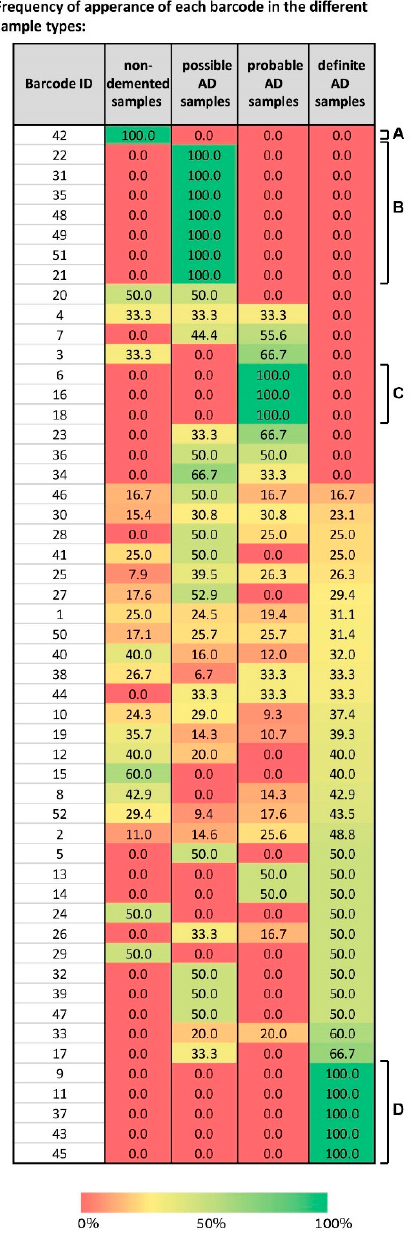
Figure 7. A spectrum of barcodes characterizes the 951 samples in the dataset, suggesting that we shift our conception of the molecular events in AD. The table presents the 52 barcodes identified in the dataset of 951 samples. For each barcode its frequency of expression in every sample type is shown. For example, blocks of barcodes characterizing solely one type of sample are evident (A, B, C, and D). However, the majority of the barcodes each characterize more than one type of sample, in di ff erent sub-combinations, suggesting that our conception of AD pathology should be shifted from biomarker-based characterization to multi-modal characterization, integrating, for example, biochemical and behavioral